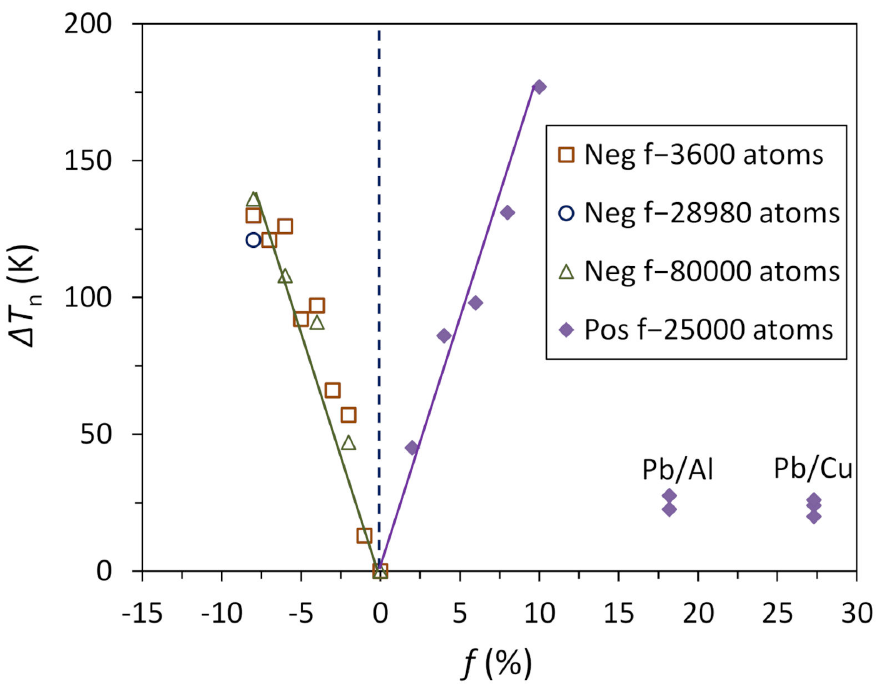
Figure 22. Nucleation undercooling v.s. lattice misfit. Nucleation undercooling ( ∆ T n ) obtained by MD simulations [11,38,39] as a function of lattice misfit ( f ) shows that ∆ T n is a complex function of lattice